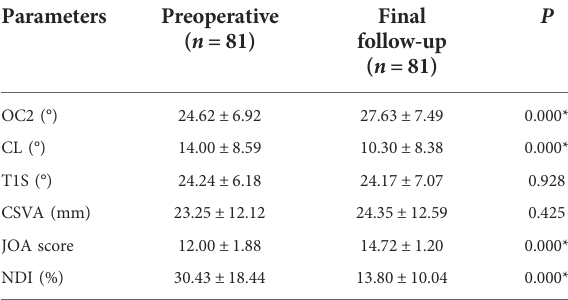
TABLE 1 Changes of radiological parameters and clinical parameters between preoperative period and fi nal follow-up